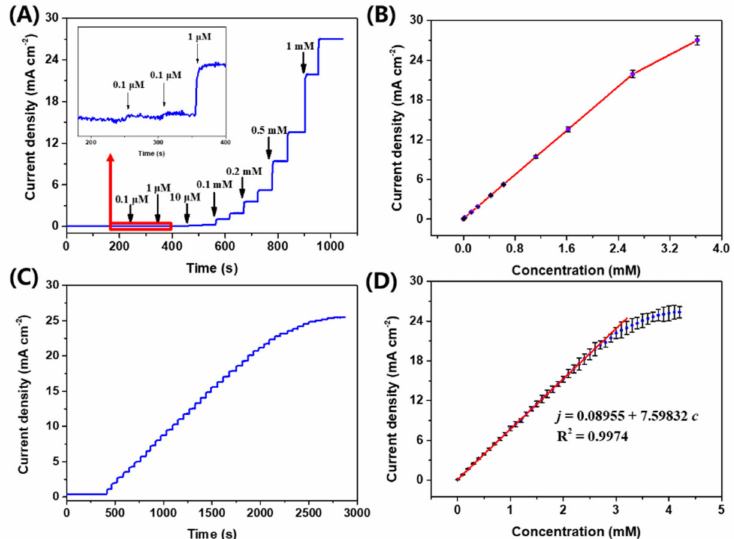
Figure 5. ( A ) Chronoamperometric response of Au@Cu(OH) 2 / CFC towards the successive additions of di ff erent concentrations of glucose. ( B ) The corresponding calibration curve of Figure A. ( C ) Chronoamperometric response of Au@Cu(OH) 2 / CFC towards the successive additions of 0.1 mM glucose. ( D ) The calibration curve for chronoamperometric response to glucose concentration in the high concentration range (corresponding to Figure C), among which the maximum RSD is